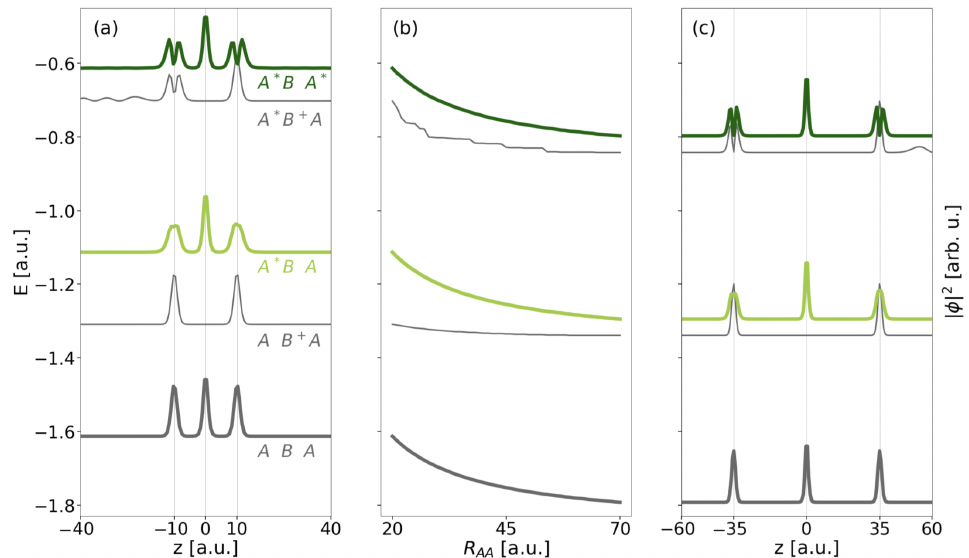
Figure 3. The energies of the key localized states of the three-electron three-QD system are displayed as a function of distance R AA (panel ( b )). From bottom to top ground state ( ABA ), first continuum state of type AB + A , lower of SE resonances A ∗ BA , first continuum state of type A ∗ B + A , and DE resonance A ∗ BA ∗ are displayed. The normalized three-electron densities | Ψ ( 0 ) | 2 in the left- and rightmost panel are leveled by the respective state energies at the given distance R AA = 20a.u. in ( a ) and 70a.u. in ( c